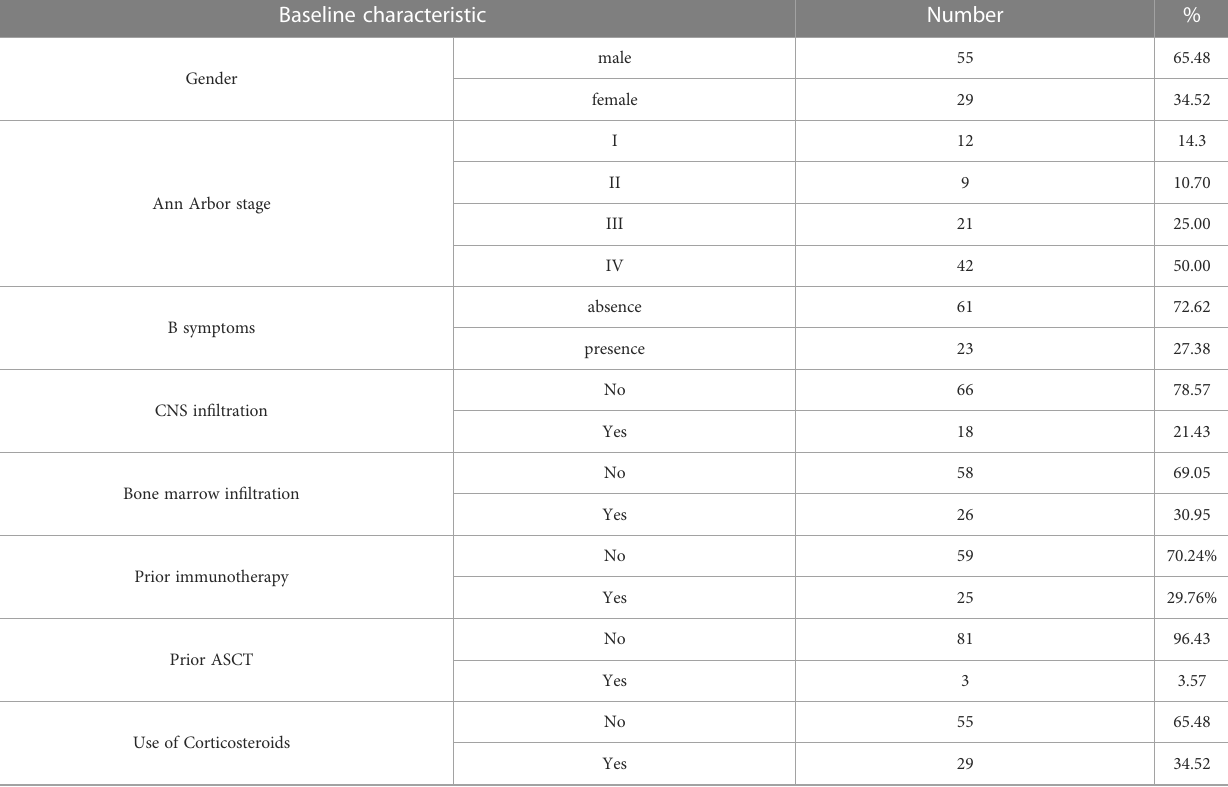
TABLE 1 Baseline characteristics of 84 patients with R/R